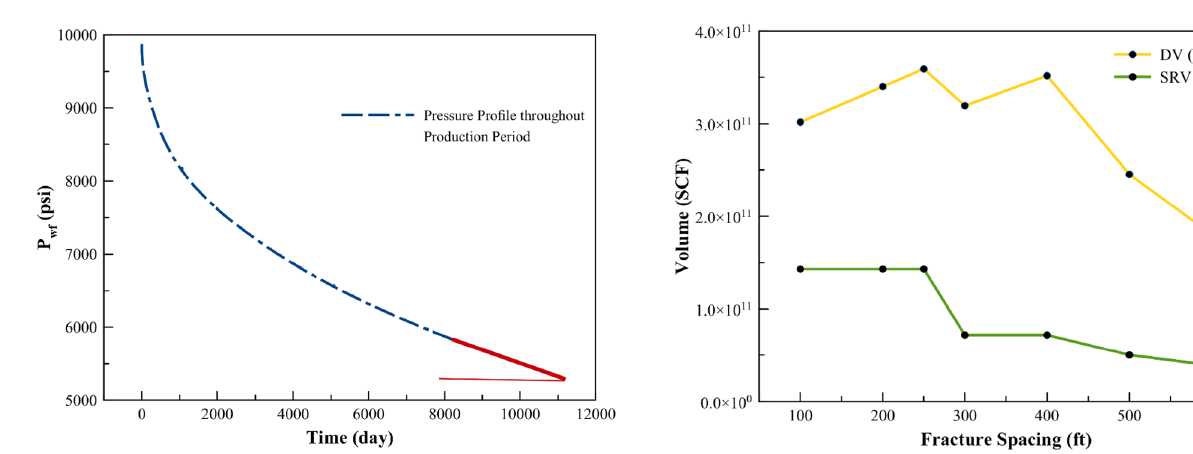
Fig. 9 SRV-DV comparison of lateral length sensitivity